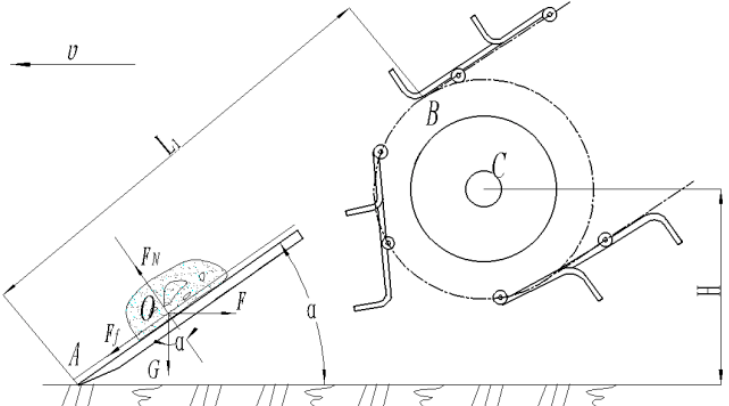
Figure 4. Force analysis diagram of the film and solids mixture. A is the vertex of the shovel; B is the tangent point of the driven chain roller in the direction of the shovel tip; C is the center of rotation of the driven chain roller; O is the center of mass of the film-soil mixture; F is the force required to lift the film-soil mixture along the shovel (N); F N is the reaction force of the shovel on the film-soil mixture (N); G is the gravitational force of the film-soil mixture on the shovel (N); F f is the friction between the shovel and the film-soil mixture (N); α is the angle of entry of the shovel (°); H is vertical distance from the shovel tip to the center of the driven chain roller (mm), and L 1 is the distance from the shovel tip to the center of the driven chain roller(mm).